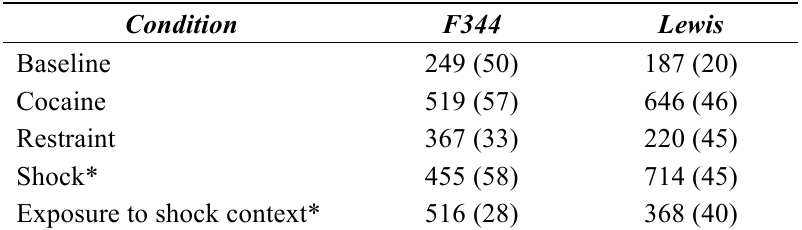
Table 3. Corticosterone levels after cocaine and stress exposures . Mean (± S.E.M.) corticosterone (ng/mL) levels obtained after exposure to the training dose of cocaine and to the stressors in F344 and Lewis